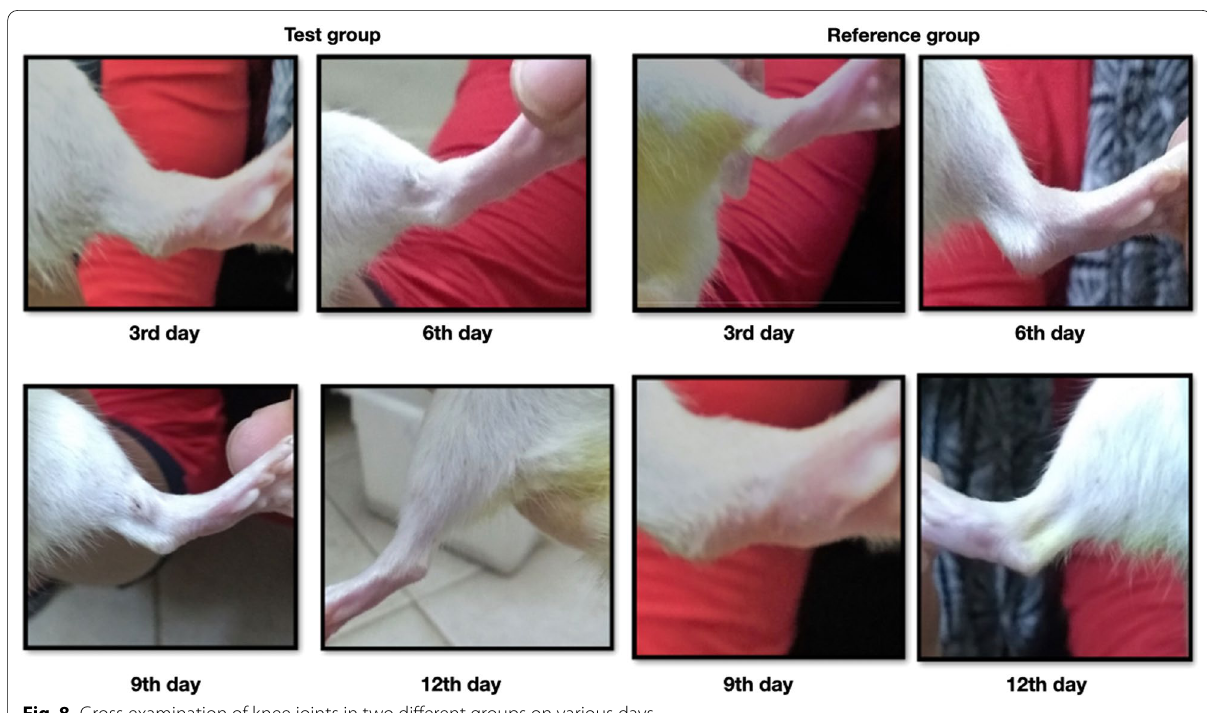
Fig. 8 Gross examination of knee joints in two different groups on various days